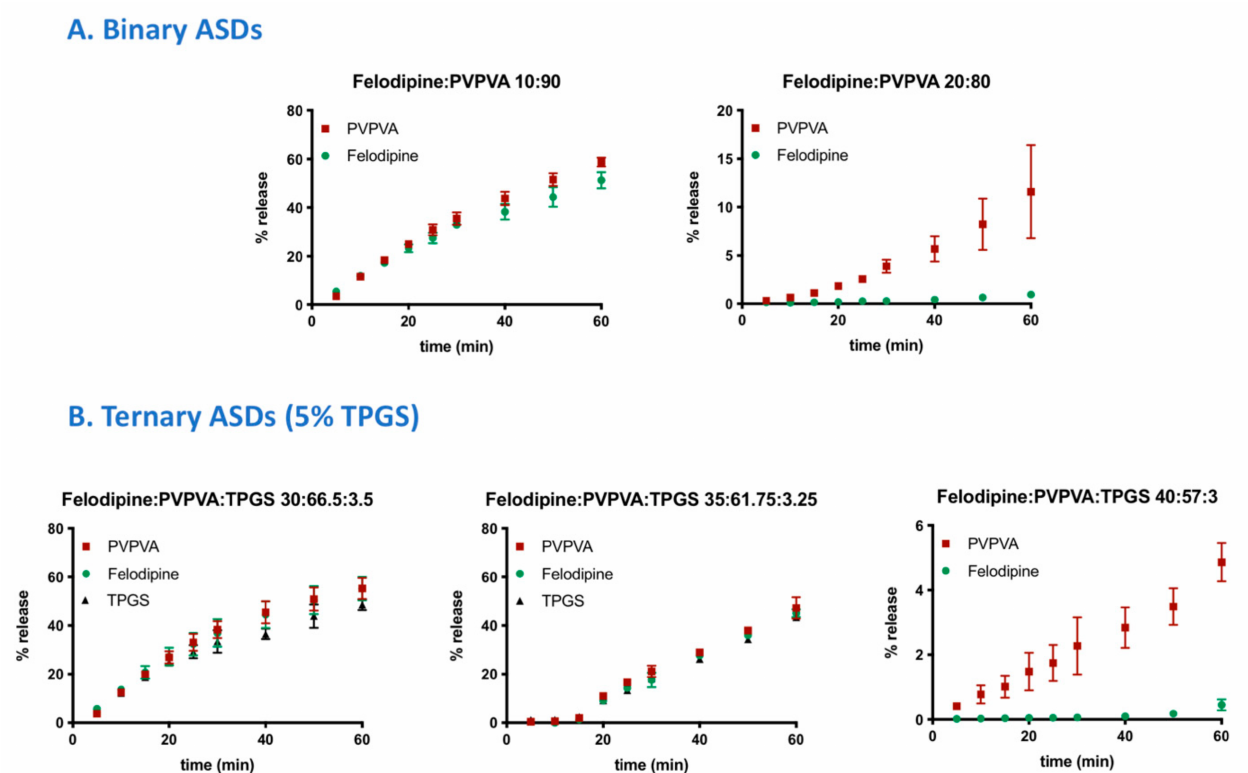
Figure 2. Comparison of the release rates of drug, polymer, and TPGS (where applicable) at drug loadings where a switch between polymer-controlled and drug-controlled release is observed. ( A ) Binary ASDs [4] and ( B ) ternary ASDs (with 5% TPGS). The ratios in the legend represent weight ratio of components in the ASDs. Error bars represent standard deviations, n = 3, and they may be smaller than symbols in some instances. TPGS levels were below the quantification limit for 40% DL ternary